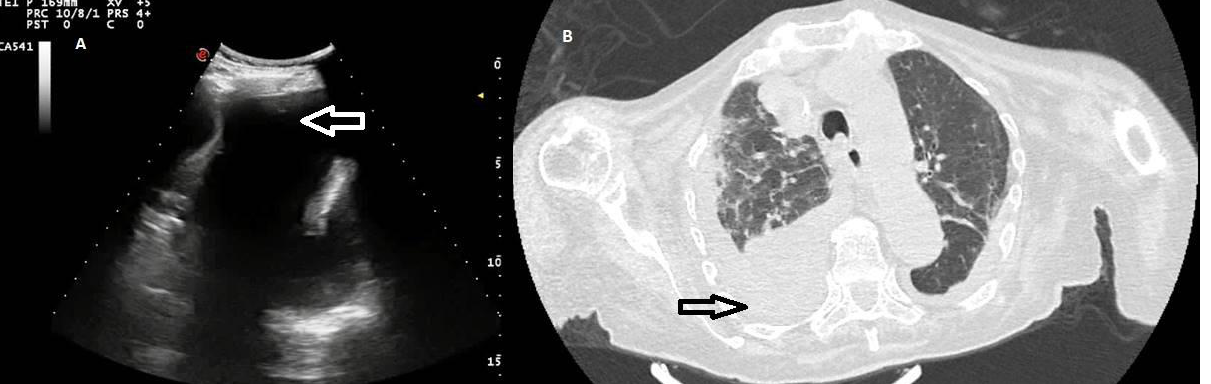
Figure 5. ( A ) TUS scan showing a complex nonseptated effusion with consensual parenchymal atelectasis. The tip of the needle during TUS-guided thoracentesis with a multifrequency convex probe (3.5 MHz) is highlighted by a white arrow. ( B ) The corresponding CT scan shows an extensive apico-parieto-basal pleural effusion of greater right expression (black arrow) with consensual lower lobe atelectasis. A bilateral thickening of interlobular septa and some right ground-glass opacities with partial sparing of the lung periphery are also present (congestive heart failure). Table 1 resumes macroscopic, microscopic and TUS description of the pleural fluid in each diagnosed clinical condition. Table 1. Macroscopic, microscopic, and TUS description of the pleural fluid according to the diag- nosed clinical condition.